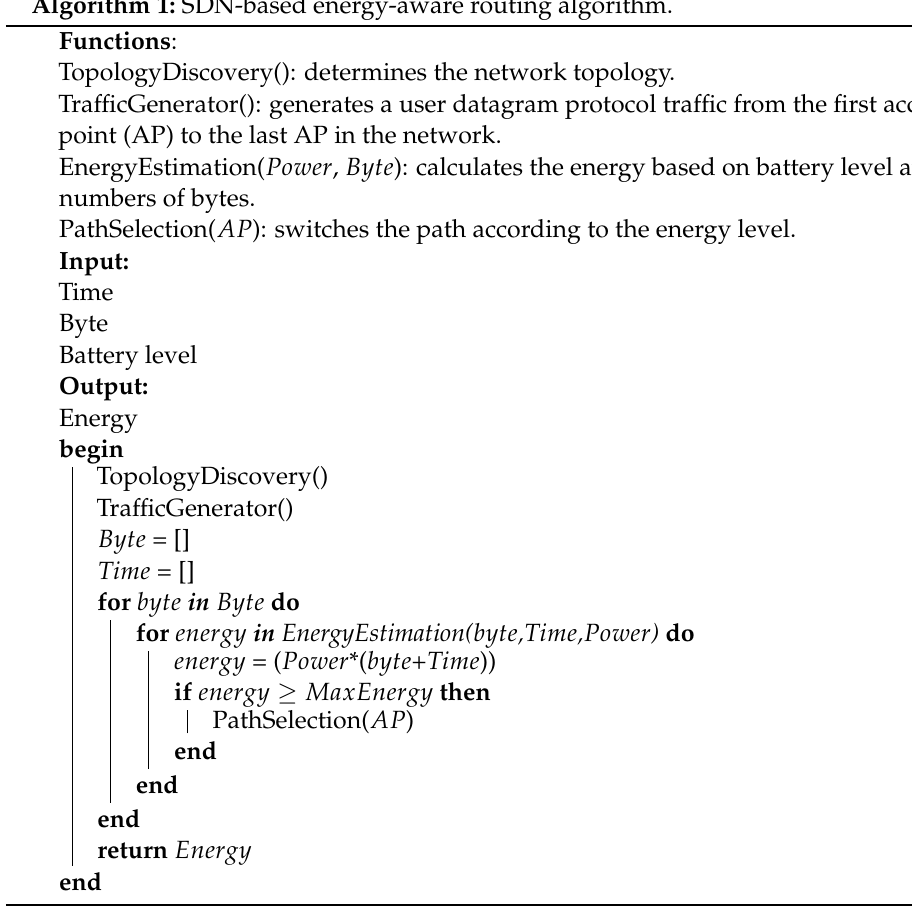
Algorithm 1: SDN-based energy-aware routing